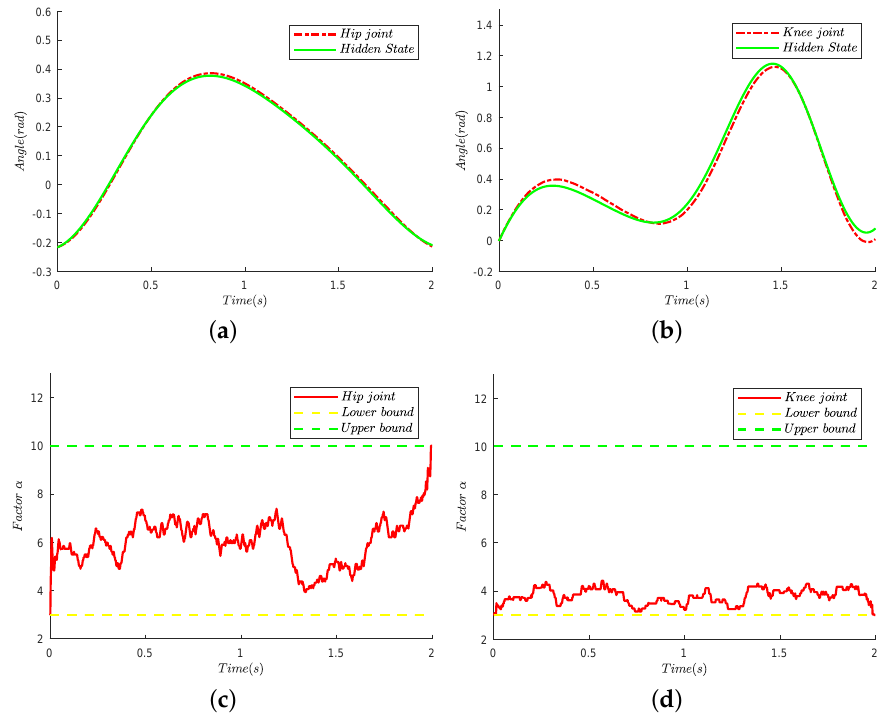
Figure 12. Tracking performances and evolution of sensitivity factors. ( a ) Tracking performance of the hip joint; ( b ) tracking performance of the knee joint; ( c ) evolution sensitivity factor of the hip joint; ( d ) evolution sensitivity factor of the knee